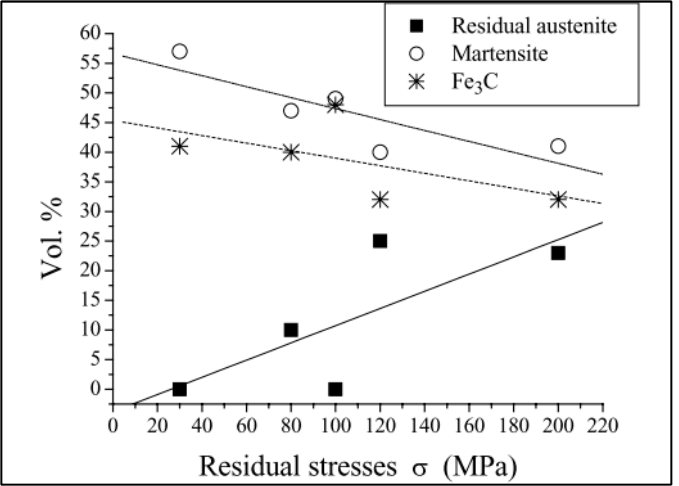
Figure 15. Evolution of residual stresses at the ductile iron surface as a function of volumetric % of phase constituents (reprinted from Reference (Reprinted with permission from ref. [65]. 2005 Inderscience Enterprises Ltd.).